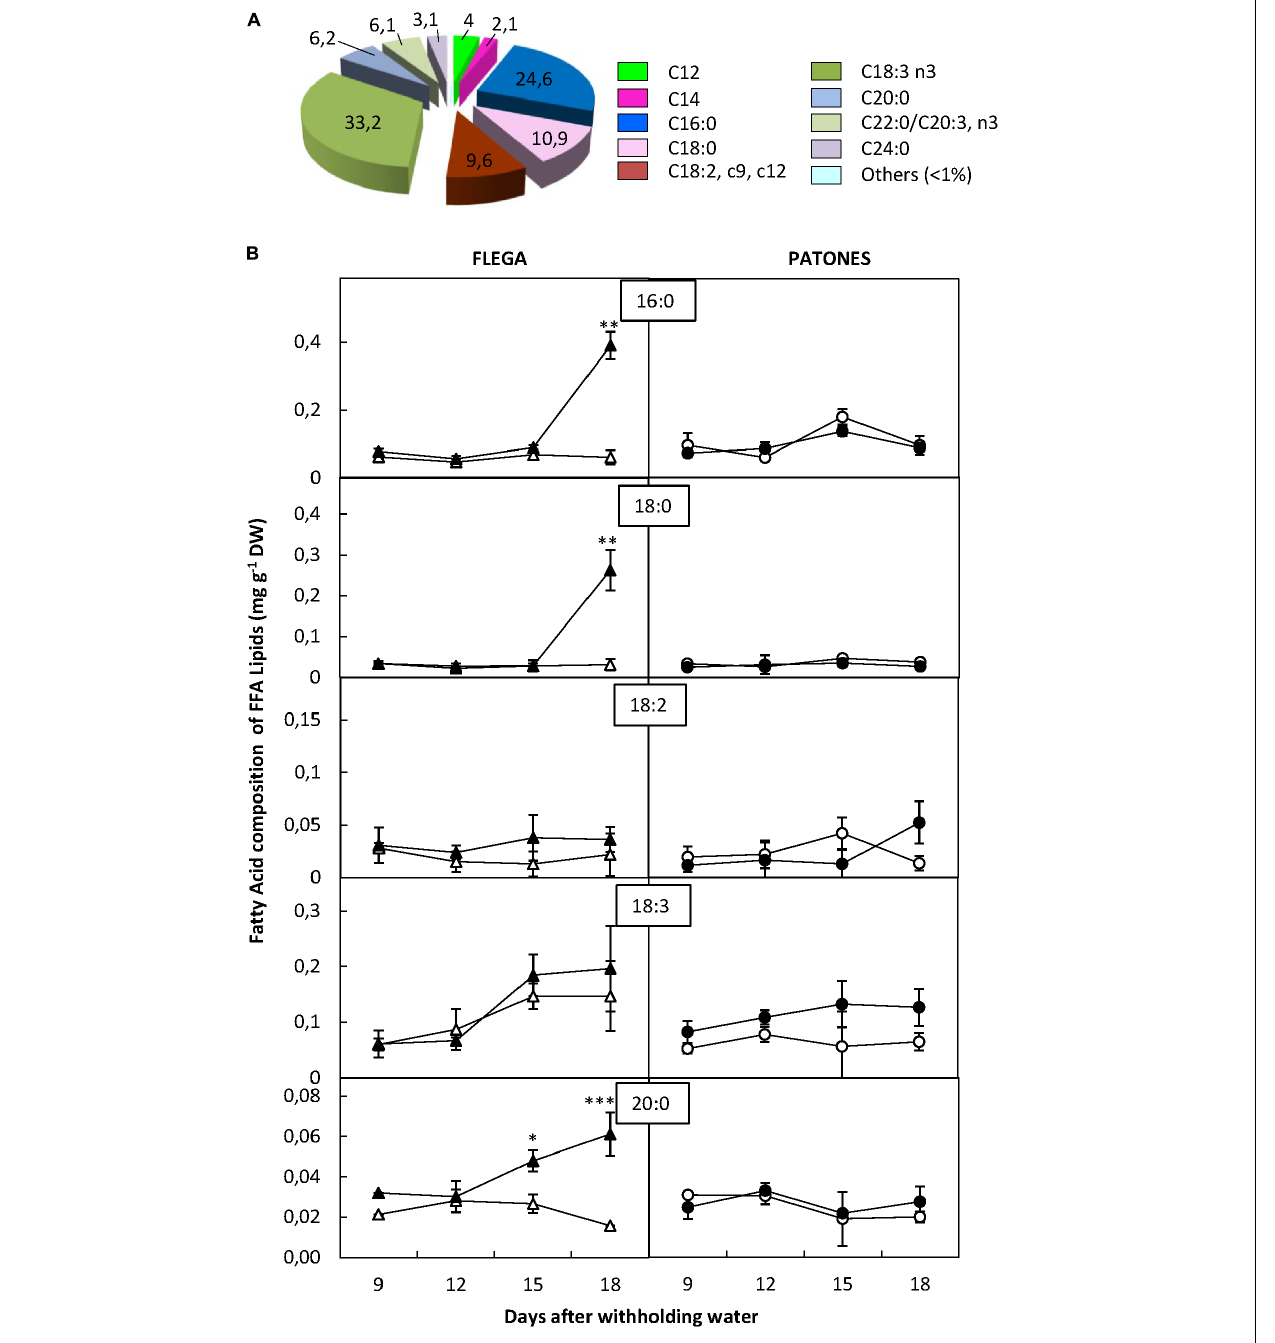
FIGURE 6 | Fatty acid content of free fatty acid fraction. (A) Fatty acid distribution within free fatty acid fraction. The proportion of fatty acids detected in the fraction was calculated from a profiling of 92 fatty acids. (B) Fatty acid content. Four major fatty acid of the fraction were quantified in drought susceptible Flega (triangles) and resistant Patones (circles) well-watered plants (open symbols) and during a time course of water stress (solid symbols) (9, 12, 15, and 18 days). Data are mean of five replicates ± standard error. ∗ , ∗∗ , and ∗∗∗ indicate significant differences at P < 0.05, 0.01, and 0.001,